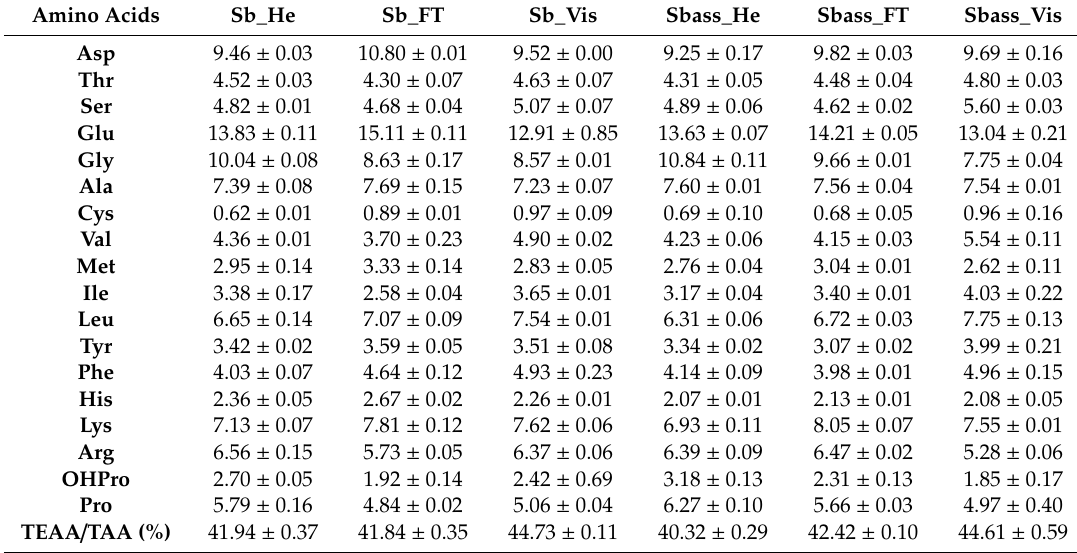
Table 4. Amino acids content of FPH from seabream and seabass by-products (% or g / 100 g total amino acids). OHPro: hydroxyproline. TEAA / TAA: ratio total essential amino acids for human / total amino acids. Errors are the confidence intervals for n = 2 (replicates of independent batches) and α = 0.05. Amino